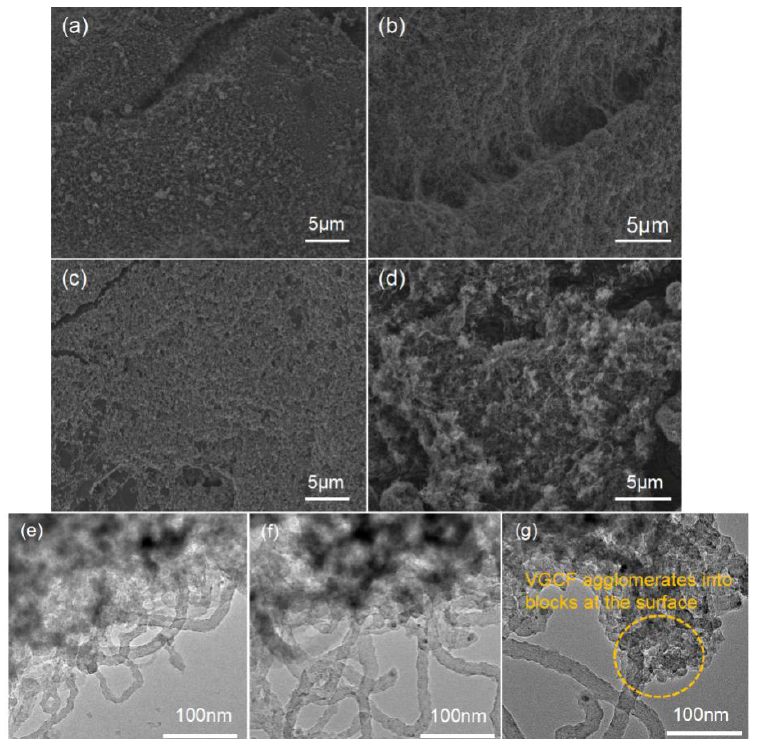
Figure 2. Comparison of morphologies between commercial carbon nanotubes and CVD deposited carbon nanofibers at different temperatures: ( a ) SEM, 600 ° C; ( b ) SEM, 700 ° C; ( c ) SEM, 800 ° C; ( d ) MWCNTs; ( e ) the TEM of the surface of EG, 600 ° C; ( f ) the TEM of the surface of EG, 700 ° C; ( g ) the TEM of the surface of EG, 800 ° C.